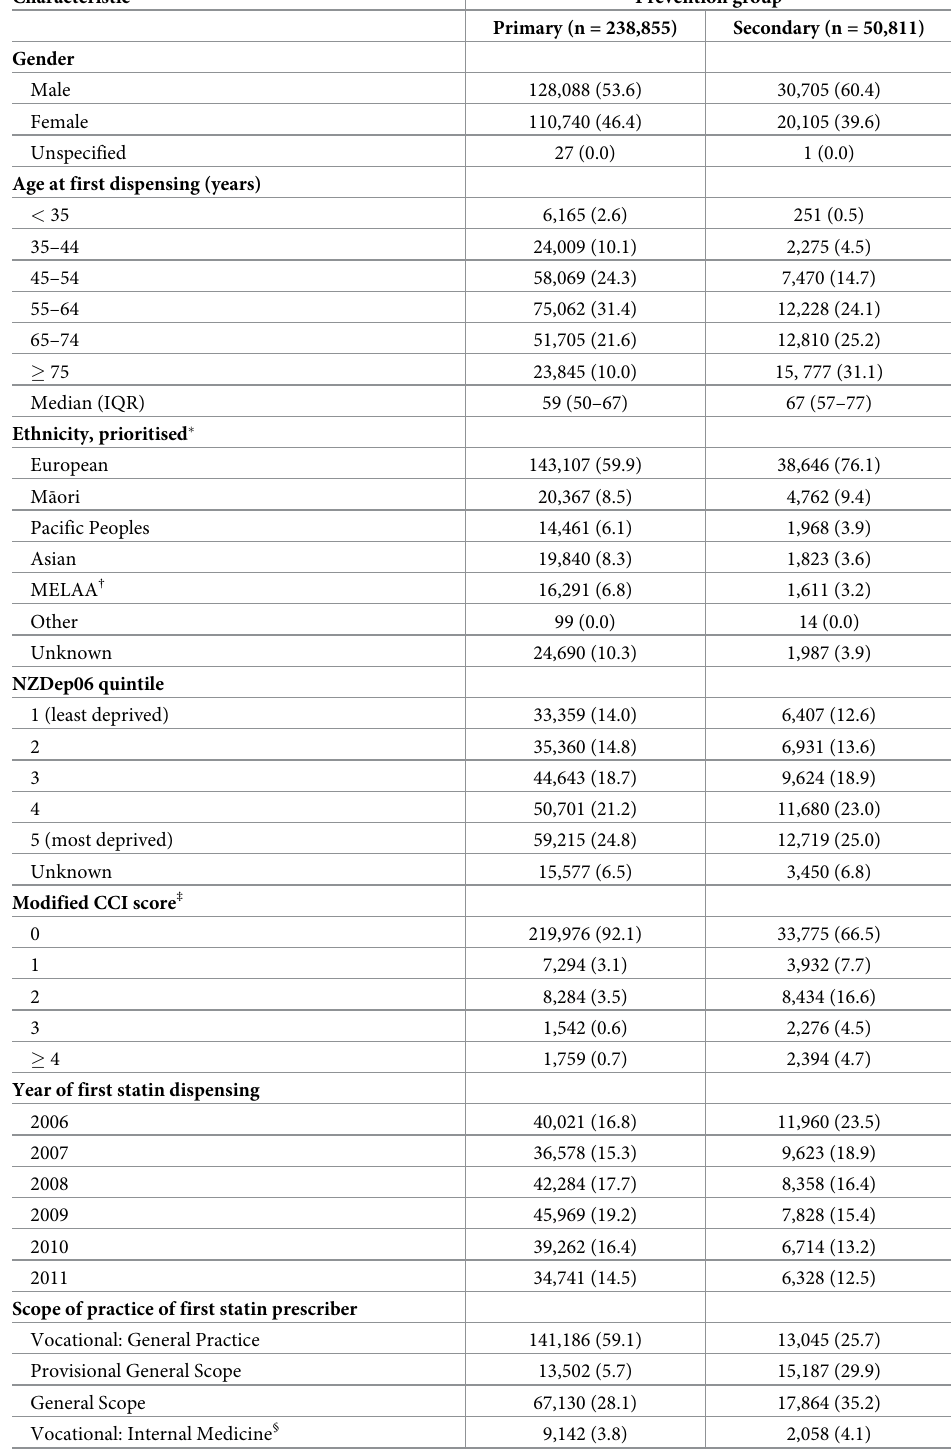
Table 1. Baseline characteristics of primary and secondary prevention groups as measured at first statin dispens- ing. Values are numbers (percentages) unless stated